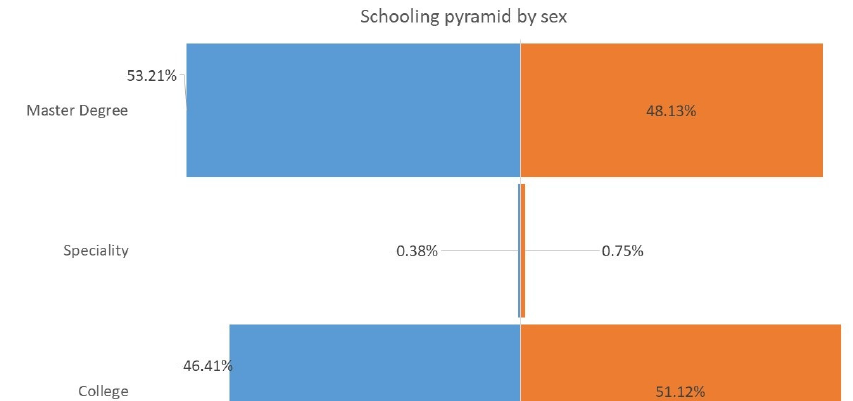
Figure 3. Yearly income level pyramid by sex. 3.2. Inferential Analyses Association between variables was assessed firstly to determine factor variables (de ‐ terminants) to be used in directional, deterministic statistical models of happiness at work and turnover intention (logistic and ordered logistic regressions). The number of observa ‐ tions varied from the independence/association analyses to logistic and ordered logistic regressions (performed each time with an n = 937) due to missing data and participants’ refusal to answer some questions. 3.3. Happiness at Work Independence between variables was assessed through chi 2 tests yielding an associ ‐ ation between happiness at work and enjoying one’s job (chi 2 = 2800, p = 0.000; n = 937) and having a purpose in life (chi 2 = 698.31, p = 0.000; n = 937), and having a job that brings you closer to your purpose in life (or life purpose oriented job: chi 2 = 900.18, p = 0.000; n = 937) and having a job deemed as valuable (chi 2 = 1100, p = 0.000; n = 937). Confounding/control variables . None of the control variables (age, gender, and income) had a significant association with happiness at work, nor did they interact with the other variables in predicting or explaining it.